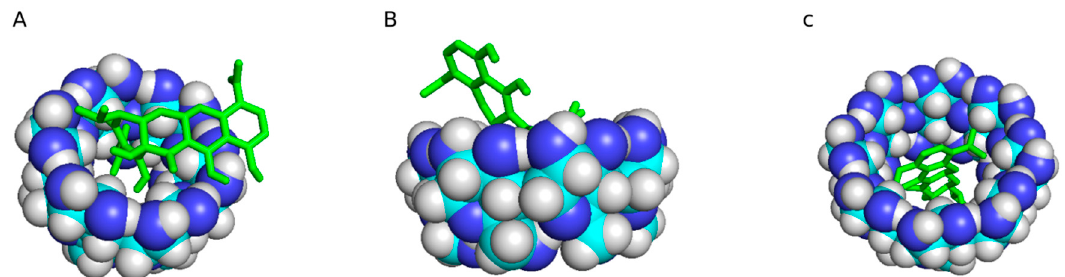
Figure 3. Autodock binding simulations showed a clear increasing trend in binding energies. Minocycline binds to (a) α CD ( − 5.1 kcal/mol); (b) < β CD ( − 6.0 kcal/mol); and (c) < γ CD ( − 7.4 kcal/mol). The Autodock simulations do not account for the potential impact of cross linking on pocket size, accessibility, or binding multiple pockets, which were explored empirically.